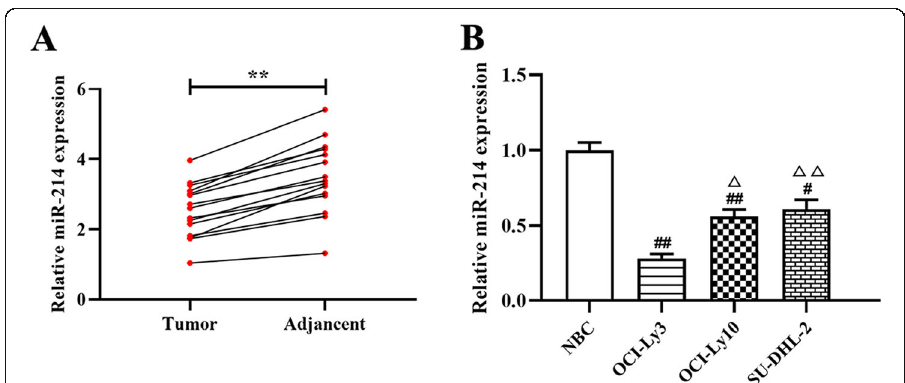
Fig. 1 The expression of miR-214 in DLBCL tissues and cell lines. a and b — Quantitative RT-PCR was used to determine the expression levels of miR-214 in DLBCL tissues ( a ) and cell lines ( b ). ** p < 0.01, compared with the adjacent normal tissues; # p < 0.05, ## p < 0.01, compared with the normal B-cell line (NBC); △ p < 0.05, △△ p < 0.01, compared with the OCI-Ly3